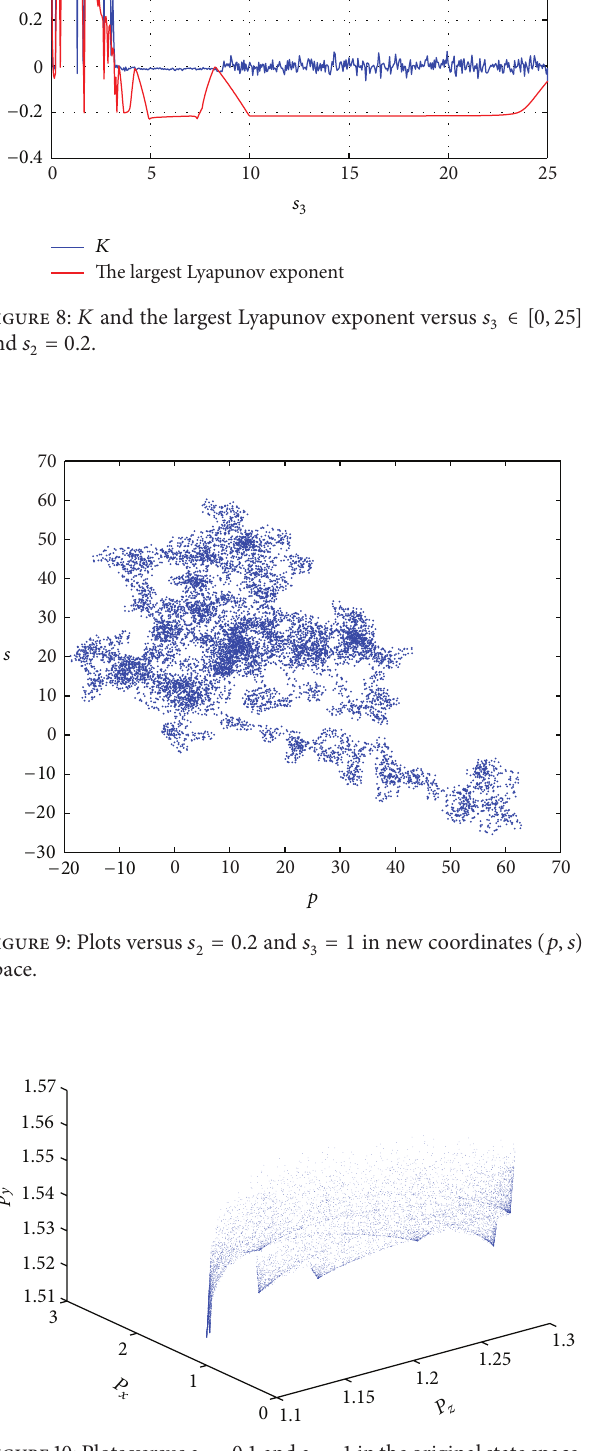
Figure 10: Plots versus 𝑠 2 = 0.1 and 𝑠 3 = 1 in the original state space.